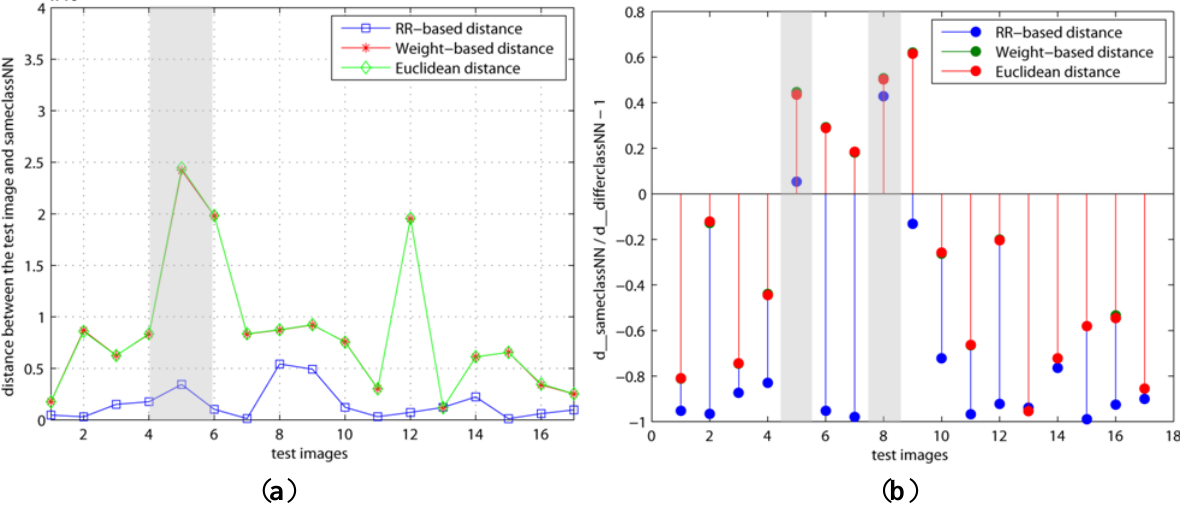
Figure 4. Variation of weights using Euclidean, weighted–based and RR-based